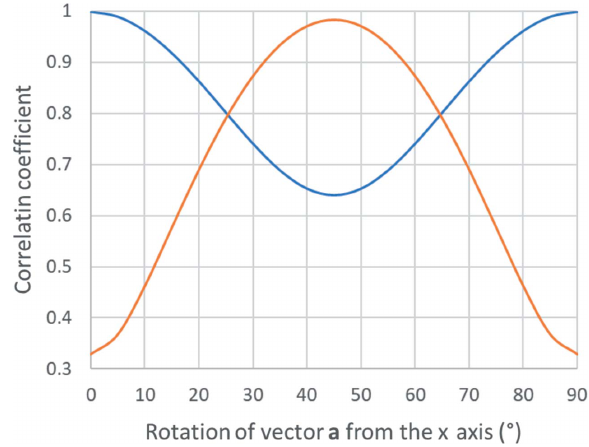
Figure 11 The correlation coefficient for the elliptical distortion for refinement under constraint of an orthorhombic crystal system. The horizonal axis represents the rotation of the crystal lattice vectors away from the orientation a || x . The phases of elliptical distortion 0 (cid:2) (blue) and 45 (cid:2) (orange) are shown and (cid:2) max was 60 (cid:2) .